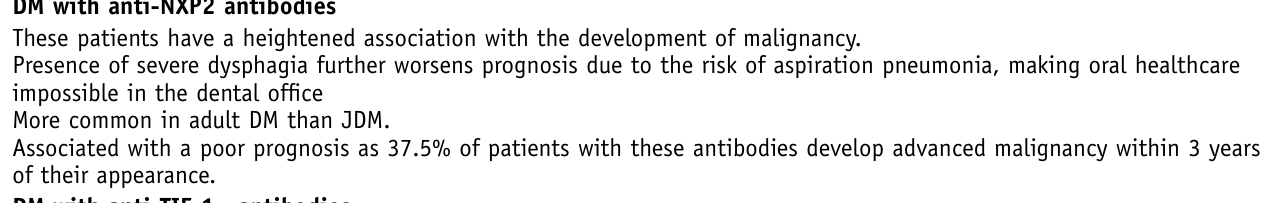
Table IV. Subgroups of dm of interest to the oral and maxillfacial surgeon. DM with anti-NXP2 antibodies These patients have a heightened association with the development of malignancy. impossible in the dental of fi